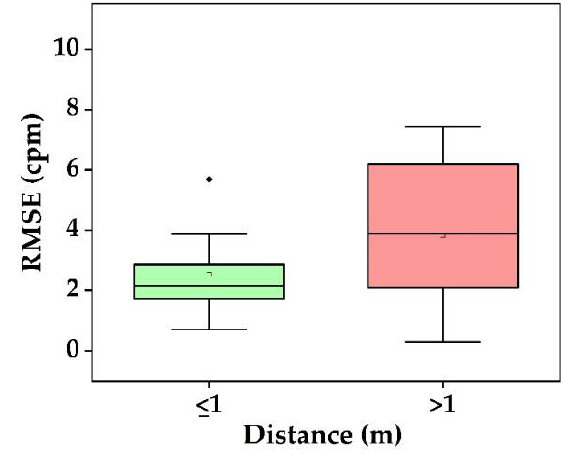
Figure 10. RMSE of RR estimation with varying distance.